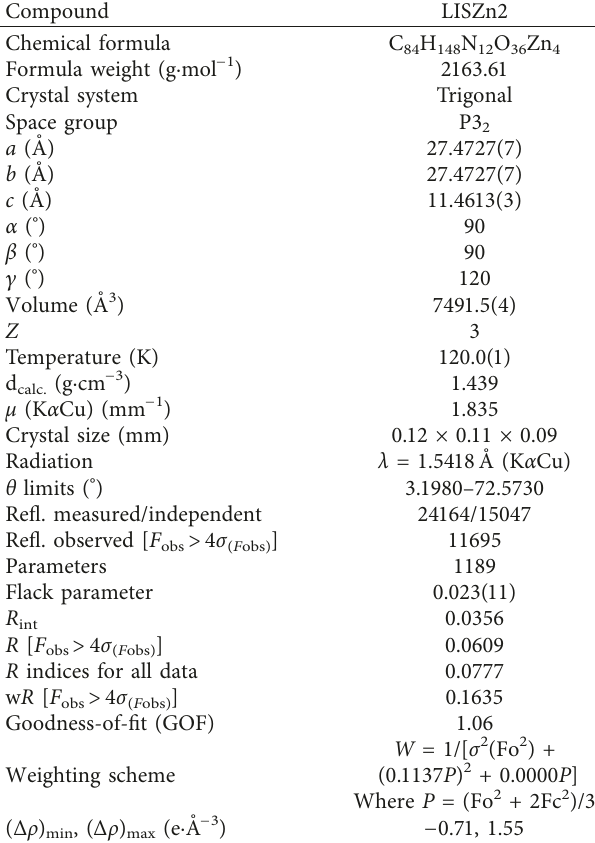
Table 2: Crystal data for LISZn2